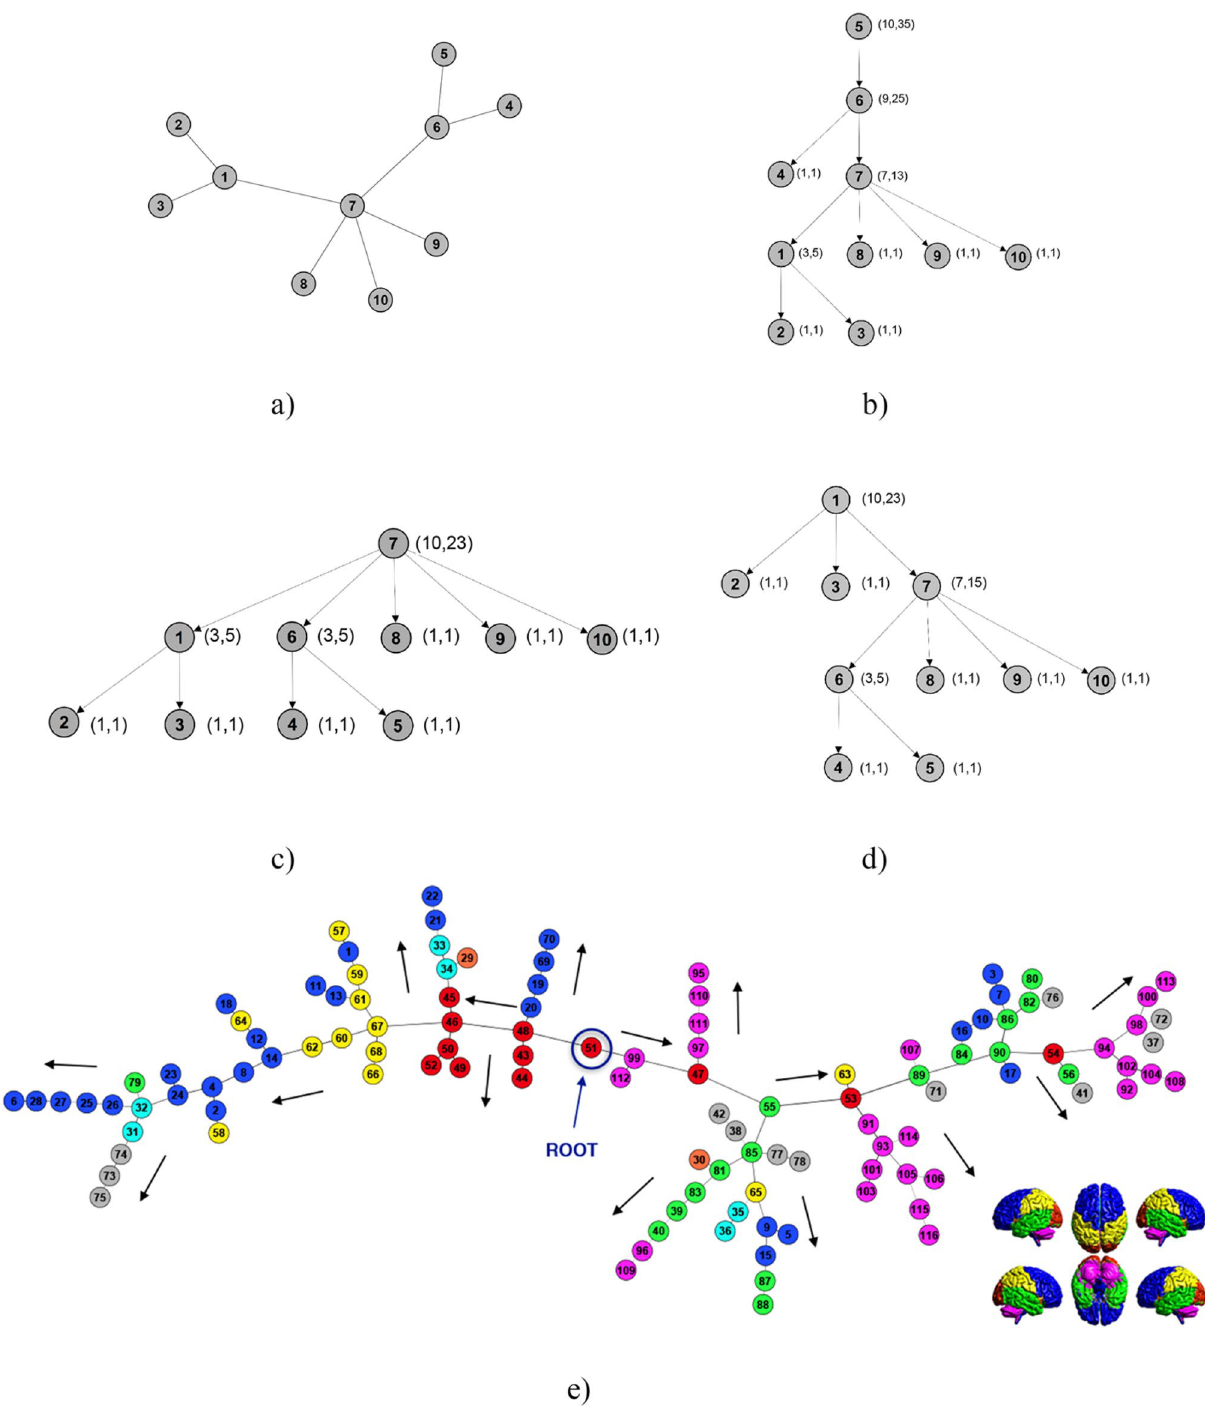
Figure 2. Allometric scale. ( a ) A toy model of 10 nodes. According to the different nodes chosen as roots, it is possible to obtain ten directed versions of the undirected tree ( a ). ( b )–( d ) Three directed versions of the tree in ( a ) with roots equal to, respectively, nodes 5, 7, and 1. Numbers in brackets represent the quantities (A i , C i ) associated with each node. ( e ) Maximum spanning tree of the human functional brain network of an individual chosen at random in healthy subjects with directionality induced by choosing node fifty-one as root. Colors in ( e ) represent anatomical regions according to the grouping of AAL parcellation shown on the right bottom: Dark blue circles: Frontal Lobe; Orange circles: Insula; Light blue circles: Cingulate; Green circles: Temporal Lobe; Red circles: Occipital Lobe; Yellow circles: Parietal Lobe; Grey circles: Deep Grey Matter; Magenta circles: